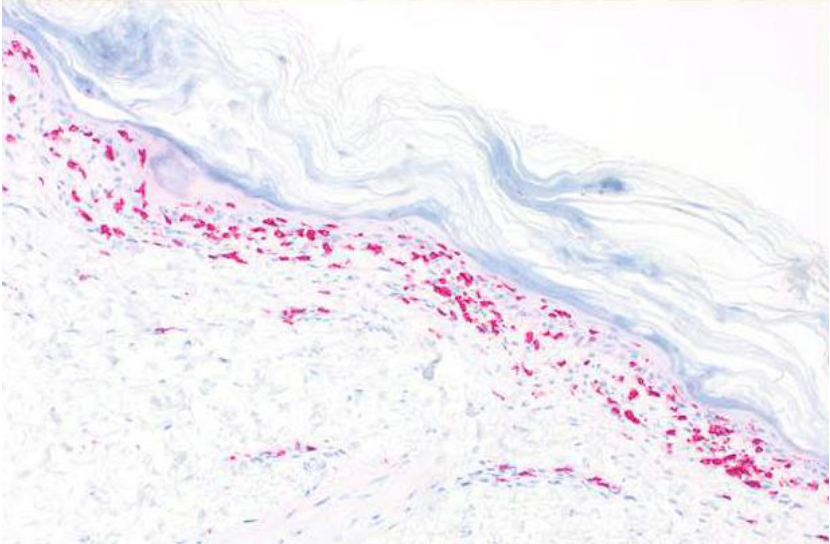
Figure 6. Immunohistology showing strong band-like immunoreactivity for CD8+ lymphocytes along the dermoepidermal junction zone, with strong epidermotropism.